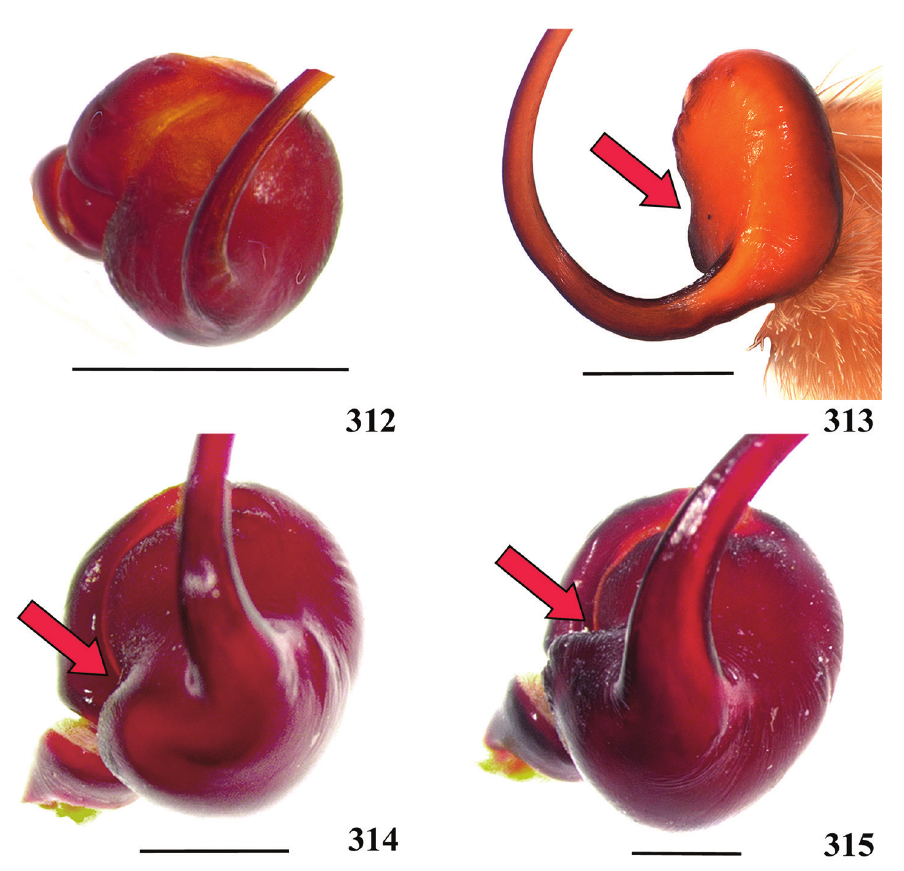
Figures 312–315. Male palpal bulb prominence in Avicularia , frontal. 312 Avicularia minatrix (MZUSP 70949), absent 313 Avicularia caei sp. n. holotype (MPEG 015637), weakly-developed 314 Avicularia bars = 1 mm. Arrows indicate groove that forms bulb